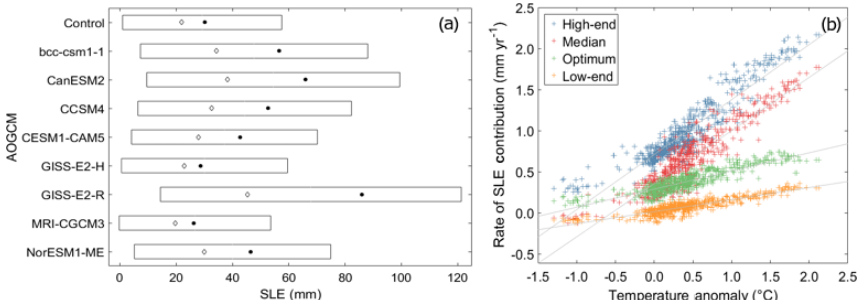
Figure 6. (a) Sea level equivalent contribution from the ASE in 2100 for each AOGCM in the subset under the RCP8.5 scenario for the range of parameter sets. The top and tail of the boxes show the high- and low-end perturbed parameter sets, respectively. The diamond and circle show the SLE contribution for the optimum and median parameter sets, respectively. (b) Rate of SLE response against ocean temperature anomaly in the ASE, averaged over the 400–700m layer, over the projection period from 2017 to 2100 for each set of